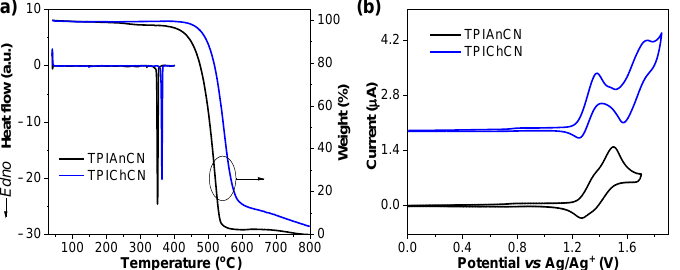
Figure 5. ( a ) TGA and DSC (2nd heating scan) plots analyzed at a heating rate of 10 °C min −1 under N 2 flow. ( b ) Cyclic voltammograms recorded in dry CH 2 Cl 2 containing n- Bu 4 NPF 6 as a supporting electrolyte at a scan rate of 50 mV s −1 under an argon atmosphere. To evaluate the electroluminescence (EL) and TTA characteristics of TPIAnCN and TPIChCN as deep blue emitters, OLED devices with the structure of indium tin oxide (ITO)/molybdenum trioxide (MoO 3 ) (10 nm)/1,1-bis[(di-4-tolylamino)phenyl]cyclohexane (TAPC) (80 nm)/tris(4-carbazoyl-9-ylphenyl)amine (TCTA) (5 nm)/emissive layer (EML) (20 nm)/1,3,5-tris[(3-pyridyl)-phen-3-yl]benzene) (TmPyPB) (40 nm)/lithium fluoride (LiF) (0.5 nm)/Al (100 nm) were fabricated and characterized as depicted in Figure 6. To achieve the optimal device EL performance, MoO 3 as hole injection layer, TAPC as hole- transporting layer, TCTA as exciton blocking layer, TmPyPB as electron transporting layer and hole blocking layer, and LiF as electron injection layer were employed. TPIAnCN and TPIChCN 5wt% doped in CBP were used as EML. A combination of suitable hole mobility and HOMO level of TAPC ( − 5.50 eV) and suitable electron mobility and LUMO level of TmPyPB ( − 2.75 eV) will conceivably confine the exciton recombination zone width in EML. The characteristic curves and device data are shown in Figure 7 and Table 2. The OLEDs based on TPIAnCN and TPIChCN demonstrated intense blue emission color with the EL emission peaks at 438 and 431 nm with CIE coordinates of (0.15, 0.07) and (0.15, 0.05), respectively. Obviously, both devices delivered a deep blue light close to the HDTV standard blue color. The EL spectra of the two devices matched well with the PL spectra of the corresponding emitters in the thin films. Remarkably, the EL emissions were rather stable with no emission peaks of TAPC (374 nm), TCTA (390 nm) [63], CBP (390 nm) [64], or TmPyPB (471 nm) [64] being seen under the whole range of applied voltages (6–10 V) (Figure S6). This suggests an efficient charge injection and recombination in the EML, and excimer emission, as well as exciplex emissions at the interfaces of EML/TmPyPB and (V on ) of 3.2 and 3.4 V for TPIAnCN and TPIChCN, respectively, indicating effective charge